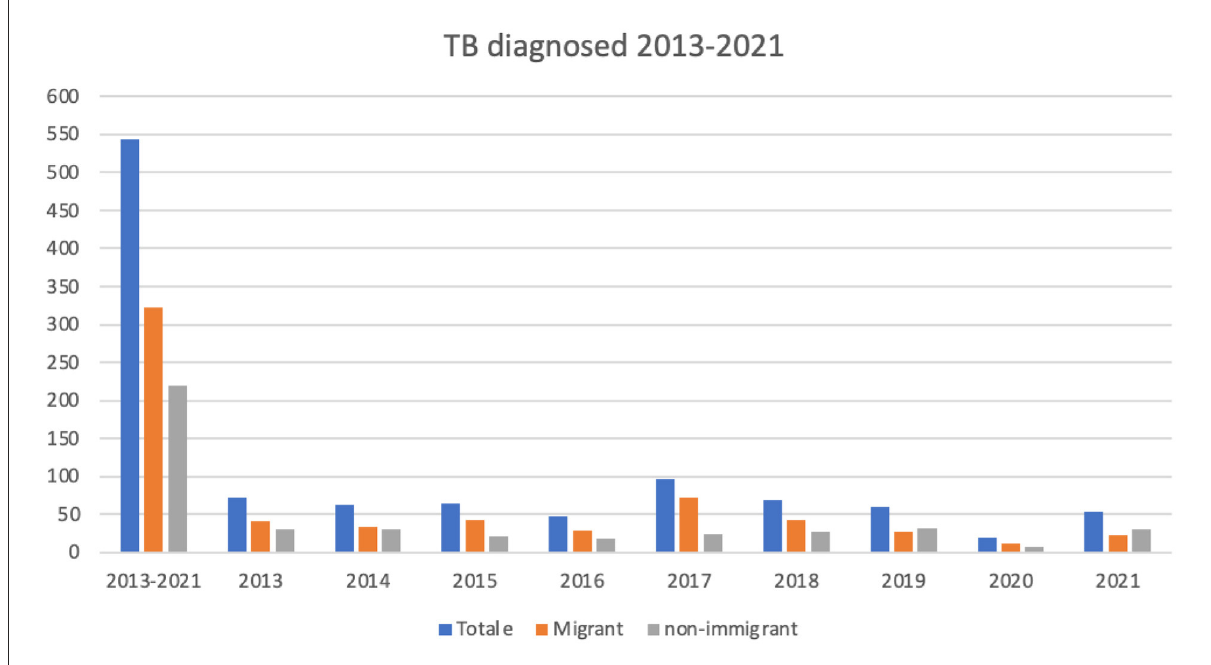
FIGURE2 Temporal trend (2013–2021) of diagnosed TB in migrant and non-migrant